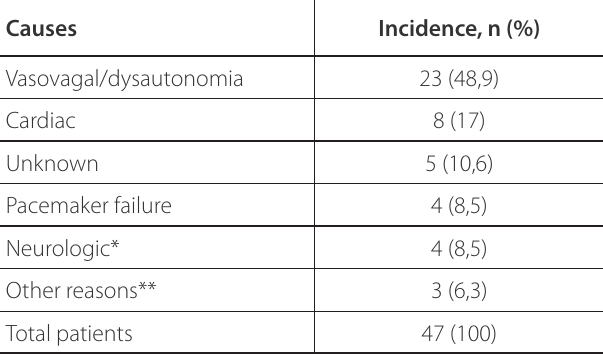
Table 2 . Causes of syncope in pacemaker